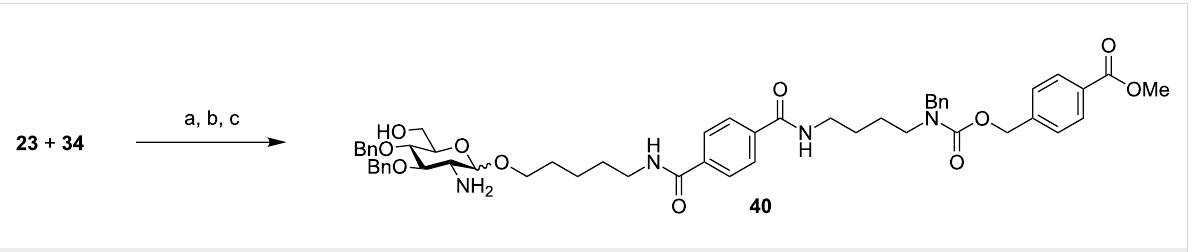
Scheme 6: Glycosylation of 34 to linker 23 and subsequent Staudinger reduction of the azide. Reactions and conditions: (a) TMSOTf, DCM, − 15 °C, 30 min; (b) PMe 3 , NEt 3 , H 2 O, THF, 25 °C, 30 min; (c) NaOMe, MeOH, DCM, rt.